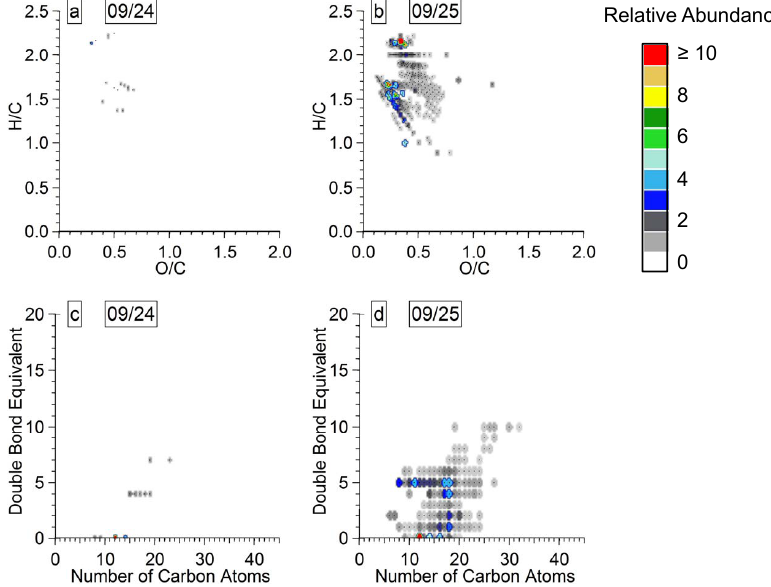
Figure 9. CHOS group species isoabundance van Krevelen diagram for 9 / 24 ( a) and 9 / 25 (b) with all detected individual ions shown as dots to facilitate visualization of CH 2 homologous series. Also shown are the double bond equivalents vs. the number of carbon atoms of the 9 / 24 (c) and 9 / 25 (d) for the CHOS group with symbol colour representing the relative